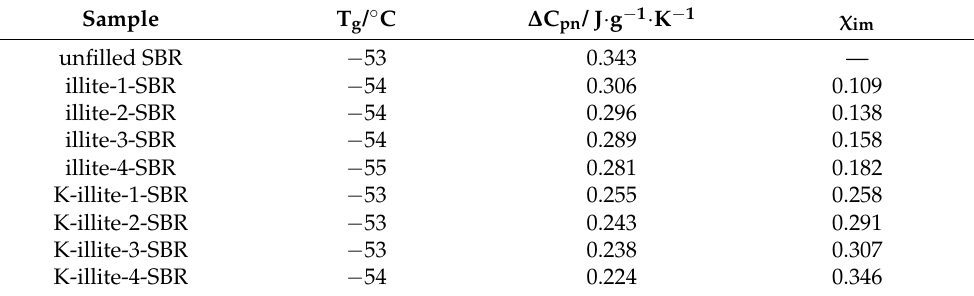
Table 4. Related data during glass transition obtained from DSC